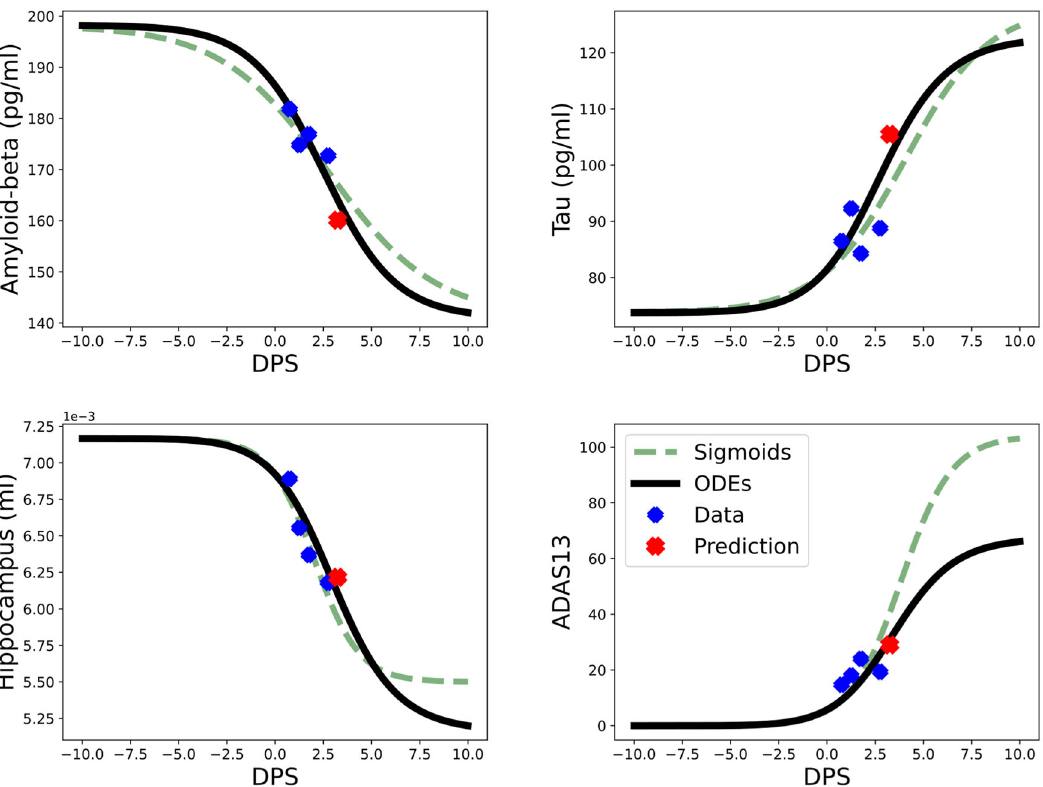
Fig. 4 The personalized model for one LMCI subject with pseudo ID = 18. The green dashed lines are fi tted by sigmoid functions, and black solid lines are the solutions of the personalized model. The blue markers are training data points while the red markers are for